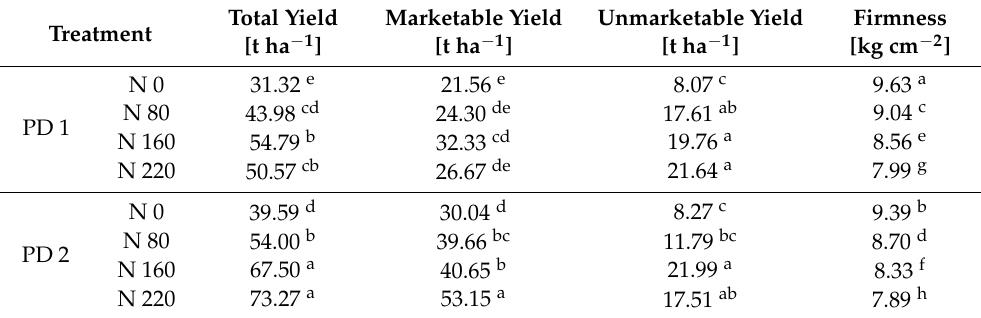
Table 4 . Influence of the interaction PD × N on the total yield, marketable yield, unmarketable yield, and firmness.